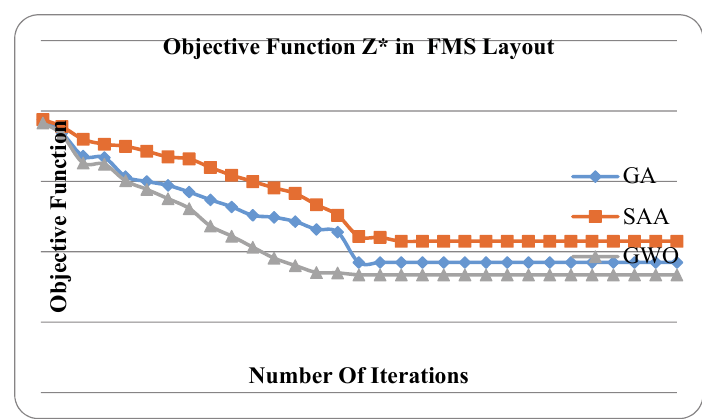
Fig. 5. Number of backtracking (B*) by AGV